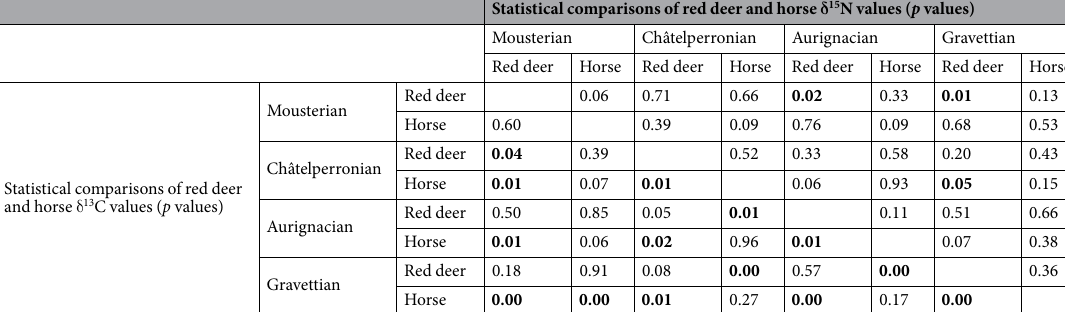
Table 8. Statistical test results comparing red deer and horse δ 15 N and δ 13 C values within each cultural period. Statistically significant p values are highlighted in bold.